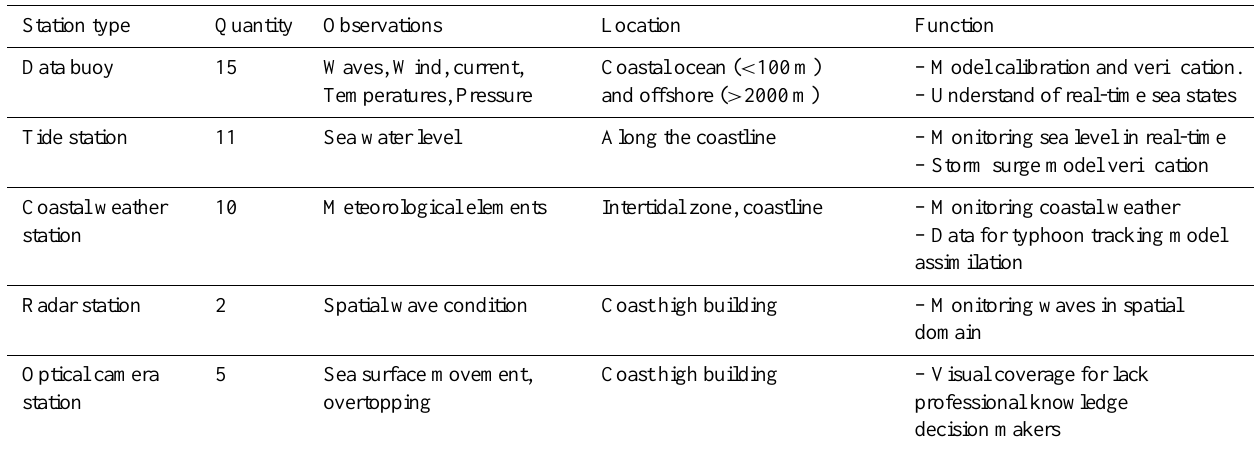
Figure 4 Coastal and ocean monitoring network in Taiwan Waters